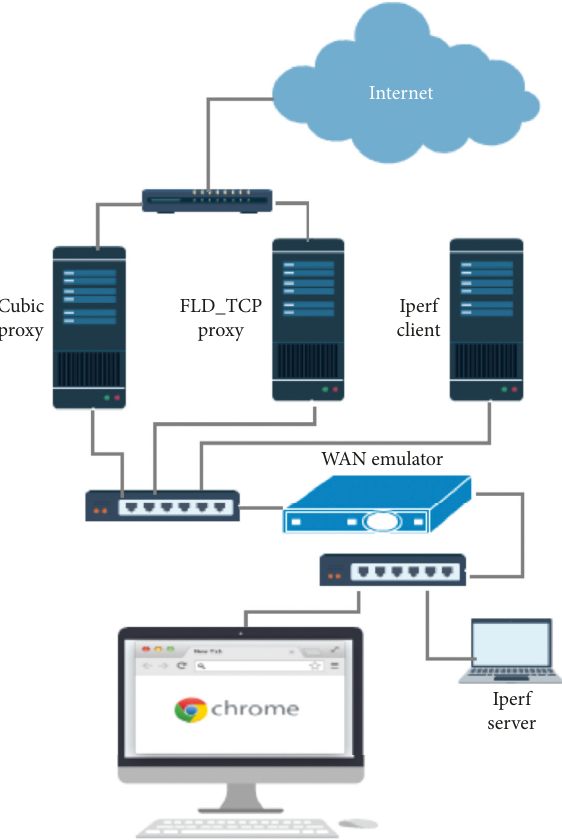
Figure 2: Evaluation